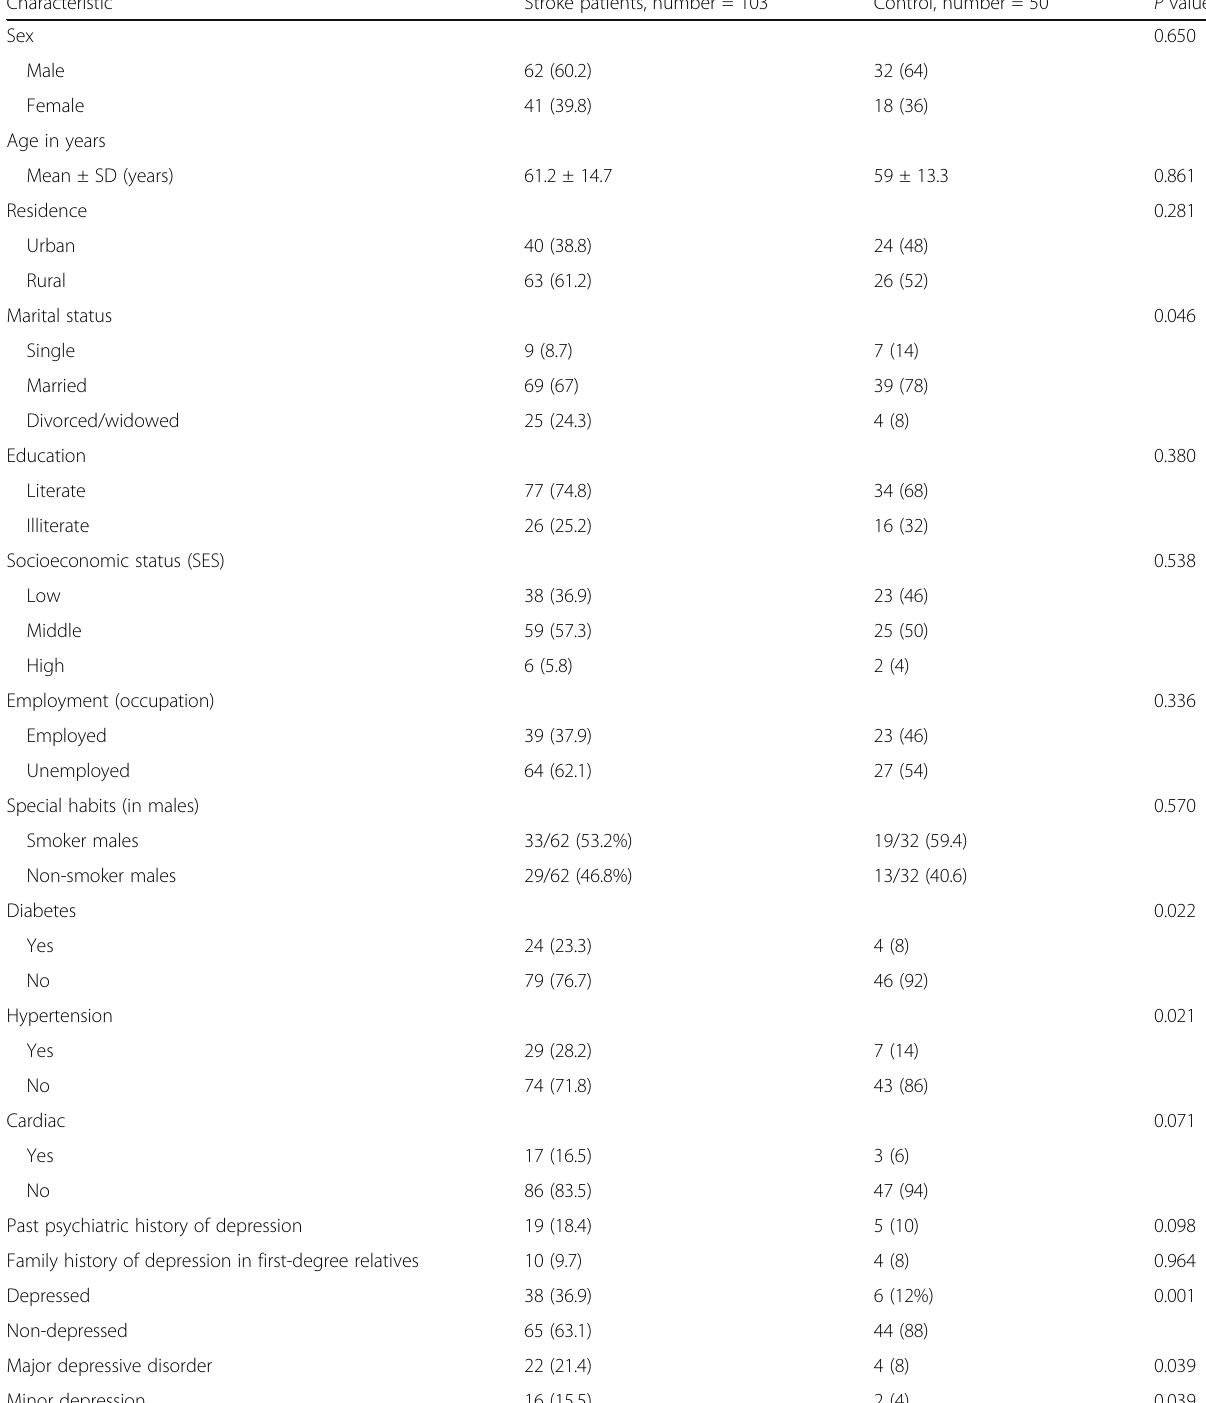
Table 1 Demographic, socioeconomic, medical, and psychiatric risk factors in stroke patients and control subjects Characteristic Stroke patients, number = 103 Control, number =